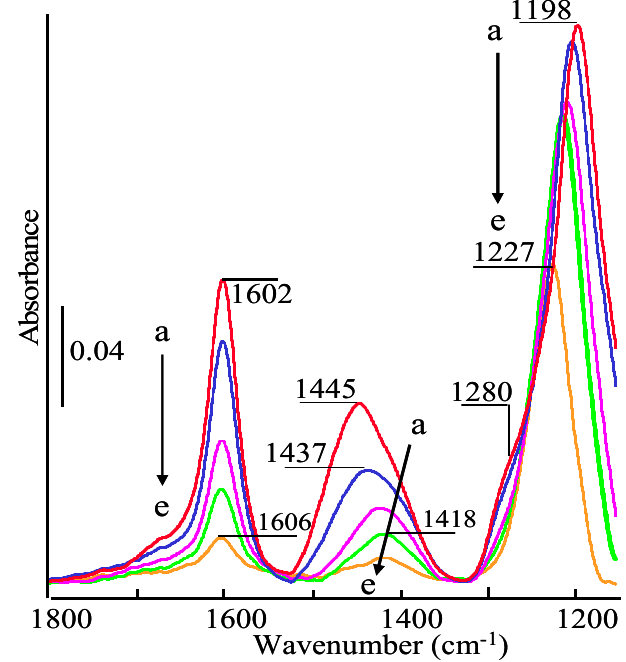
Figure 5. IR bands of adsorbed NH 3 species after adsorption of 0.1% NH 3 /He on 6% WO 3 /TiO 2 -P25 pretreated at 713 K in helium as a function of adsorption temperature T a : (a–e) T a = 300, 373, 498, 573 and 673 K.